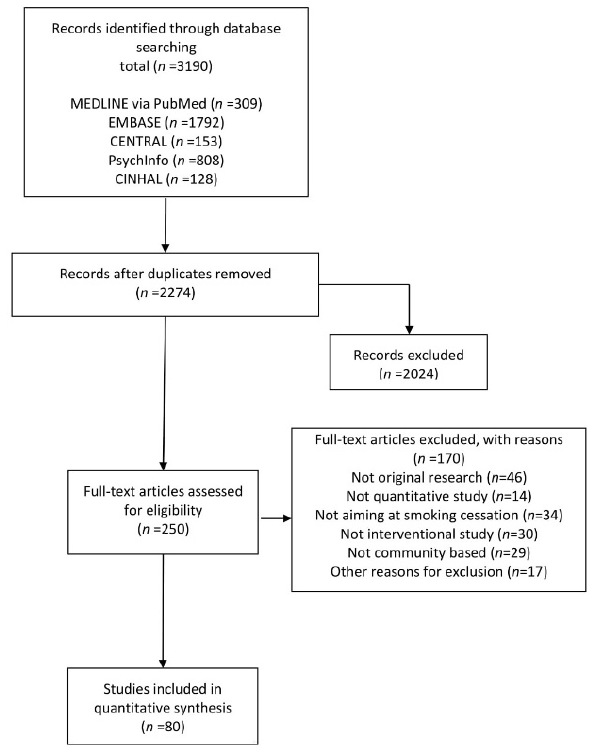
Figure 1. Flow chart showing the data search and study selection process.